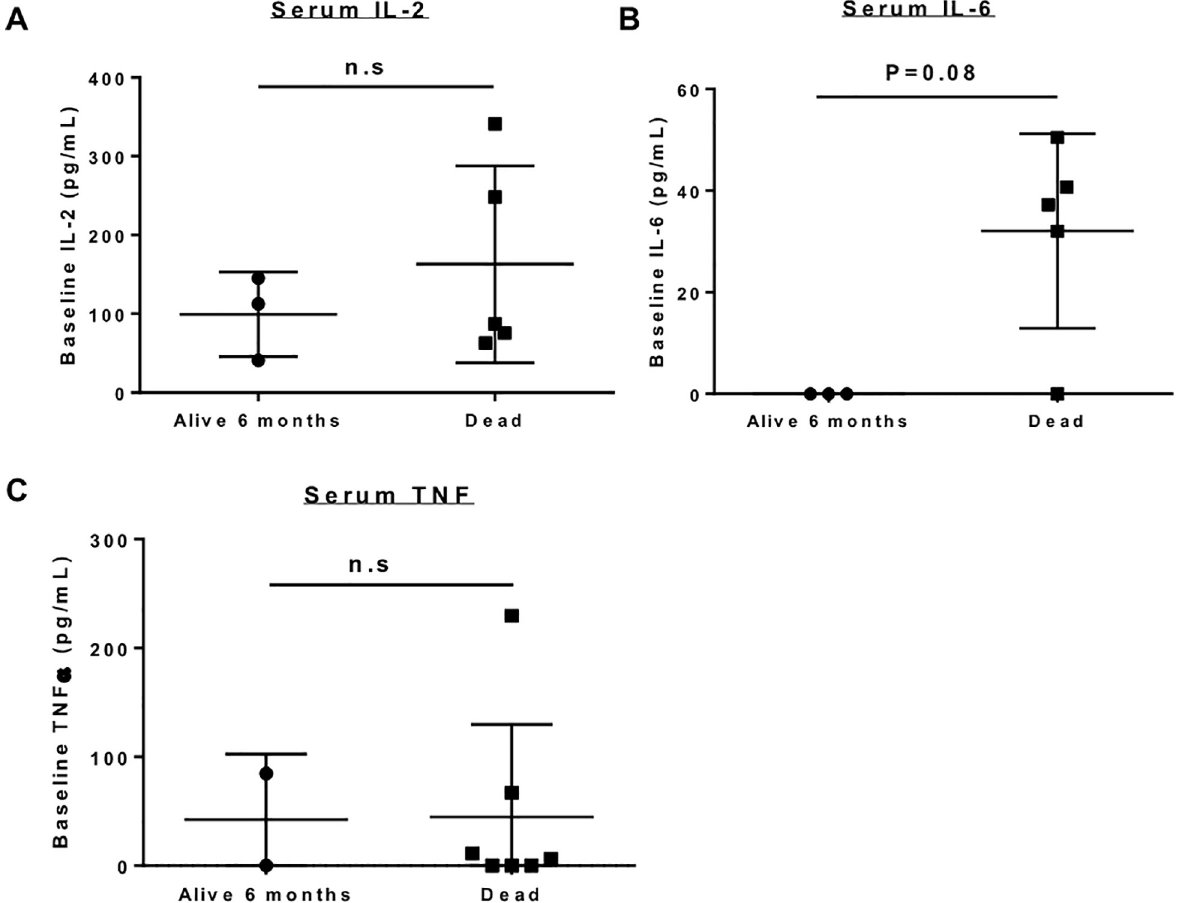
Fig 3. Baseline serum cytokine expression in trial patients. Baseline expression of serum cytokines was compared between dogs who were alive at 6 months versus those who died. There was no significant different in serum IL-2 (A) or serum TNF- α (C) between survivors and non-survivors. Baseline serum IL-6 (B) was notably higher in non- survivors (32.1 pg/mL ± 19.2) compared to survivors (not detectable), although this difference was not statistically significant (P = 0.08).